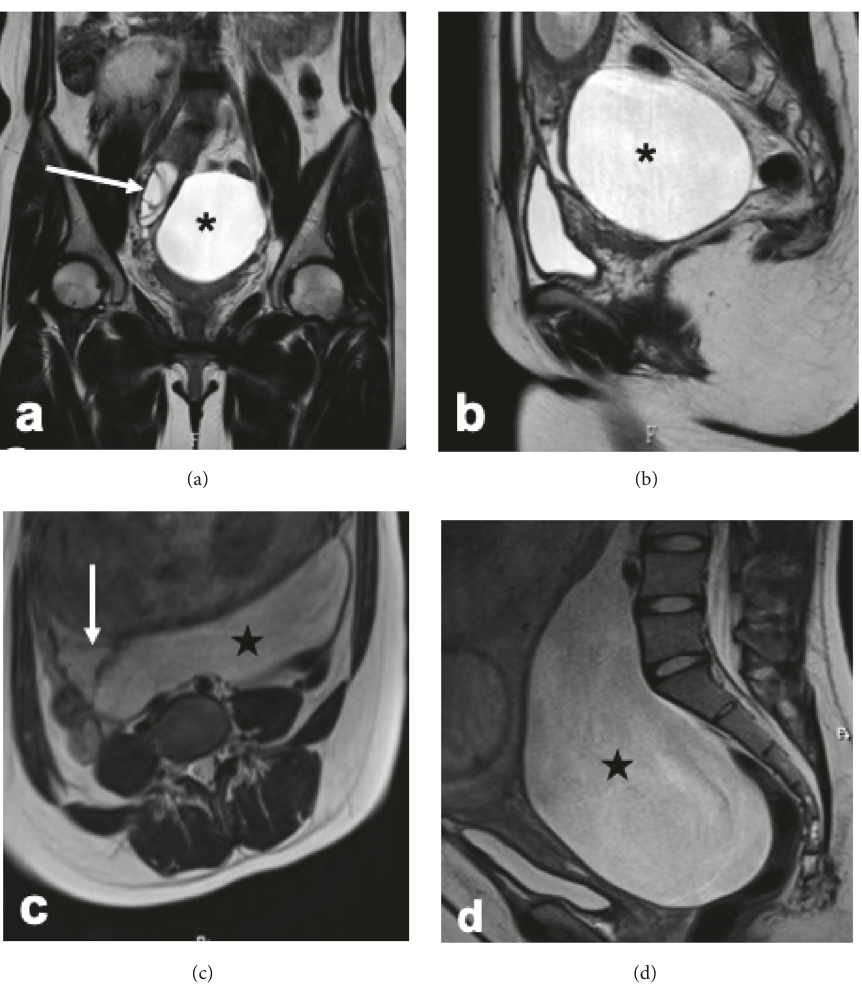
Figure 1: T2-weighed magnetic resonance imaging at 9 (a, b) and 32 (c, d) weeks of gestation. (a) Bilateral pelvic masses with a horizontal view. A right-sided multilocular mass (arrow) and left-sided unilocular mass (asterisk) are shown. We suspected bilateral ovarian tumors at this point. (b) Sagittal view. The left-sided unilocular mass (asterisk) is shown. (c) Horizontal view. The right-sided multilocular mass (arrow) is involved in or at least is located very close to the large mass (star). (d) Sagittal view. The left-sided mass (star) occupies the pelvic